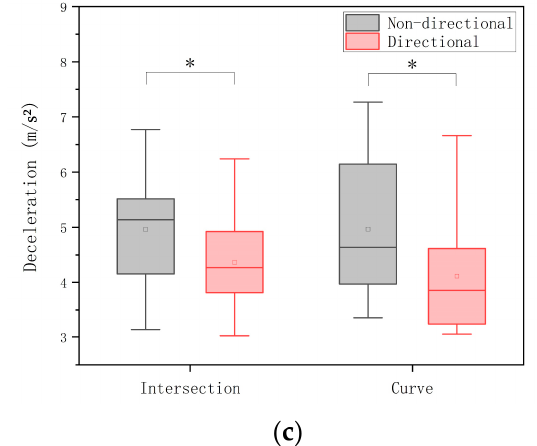
Figure 6. ( a ) Takeover time for different auditory TORs; ( b ) steering wheel angle for different auditory TORs; and ( c ) deceleration for different auditory TORs. (* p < 0.05 ; ▪ : outlier).